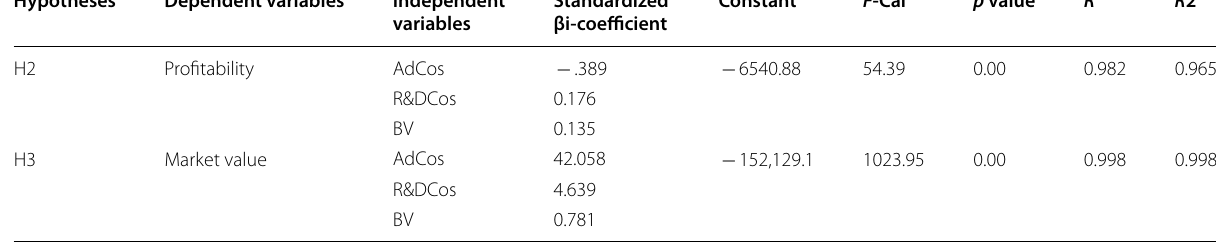
Table 7 The standard multiple regression analysis results. Source: Author’s calculations using SPSS Hypotheses